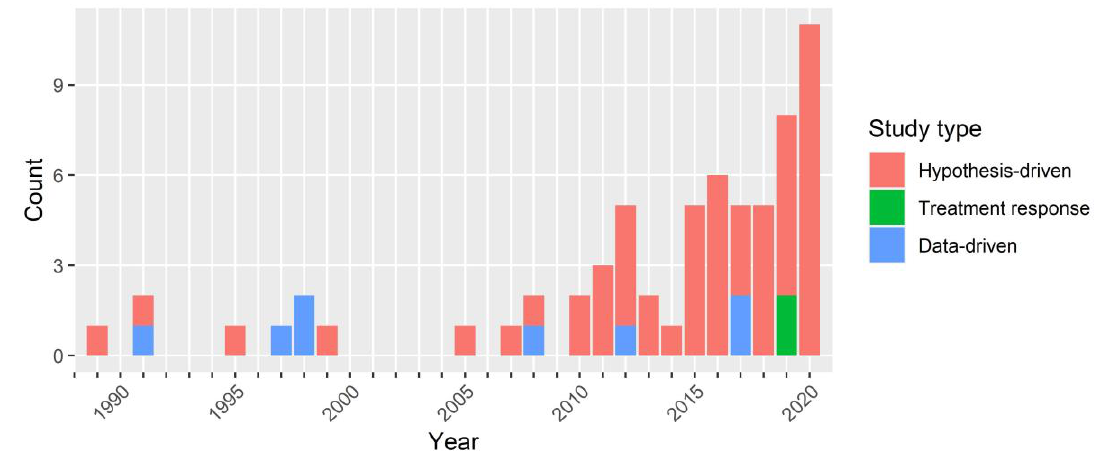
Figure 2. Publication years of included analyses.